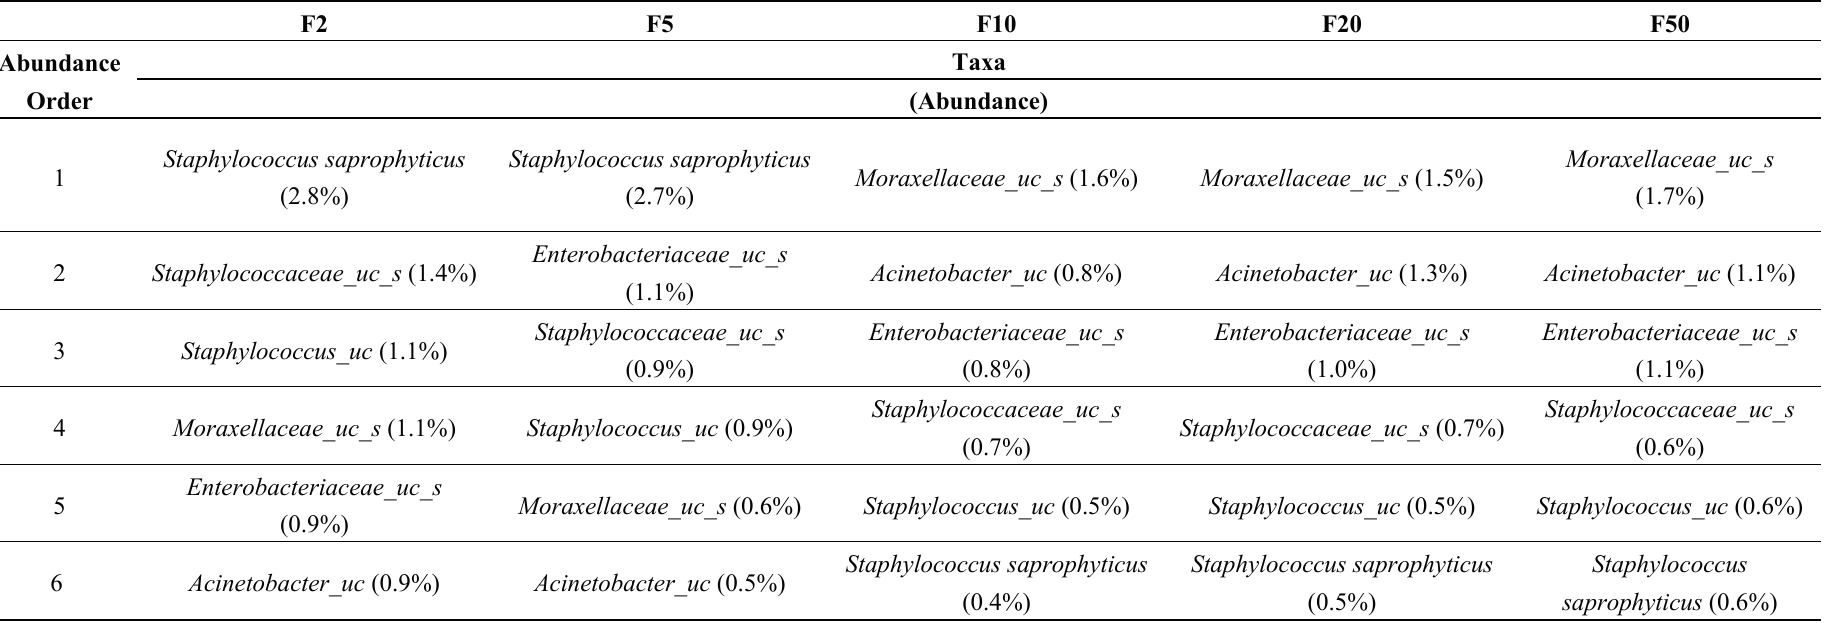
Table 2. Identities of the six most abundant OTUs in the bacterial